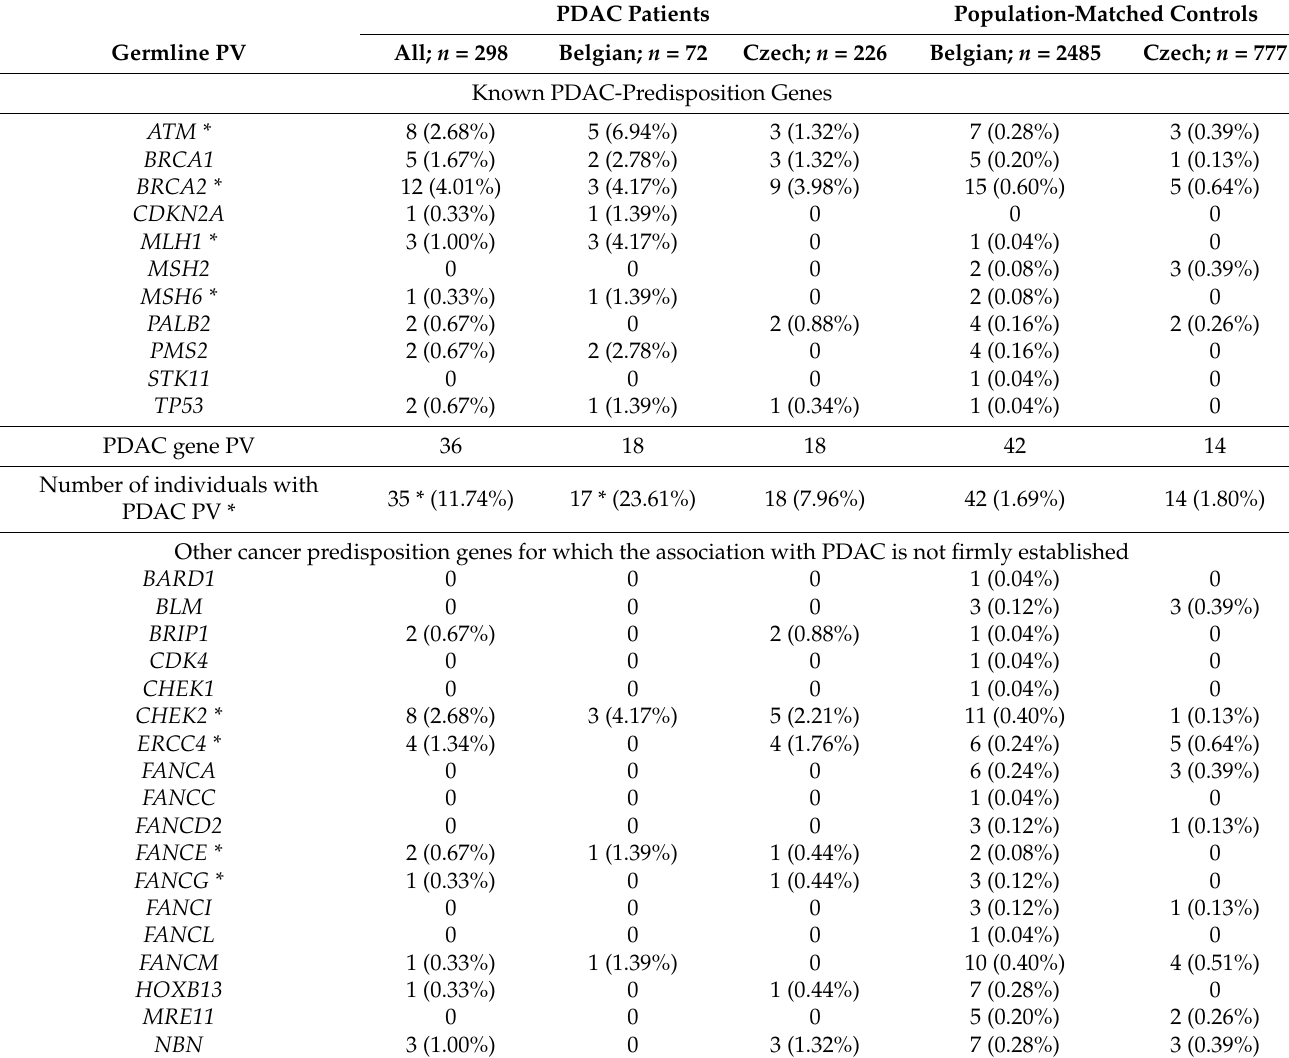
Table 2. Prevalence of pathogenic/likely pathogenic variants (PV) in Belgian/Czech patients and controls. PDAC Patients Population-Matched